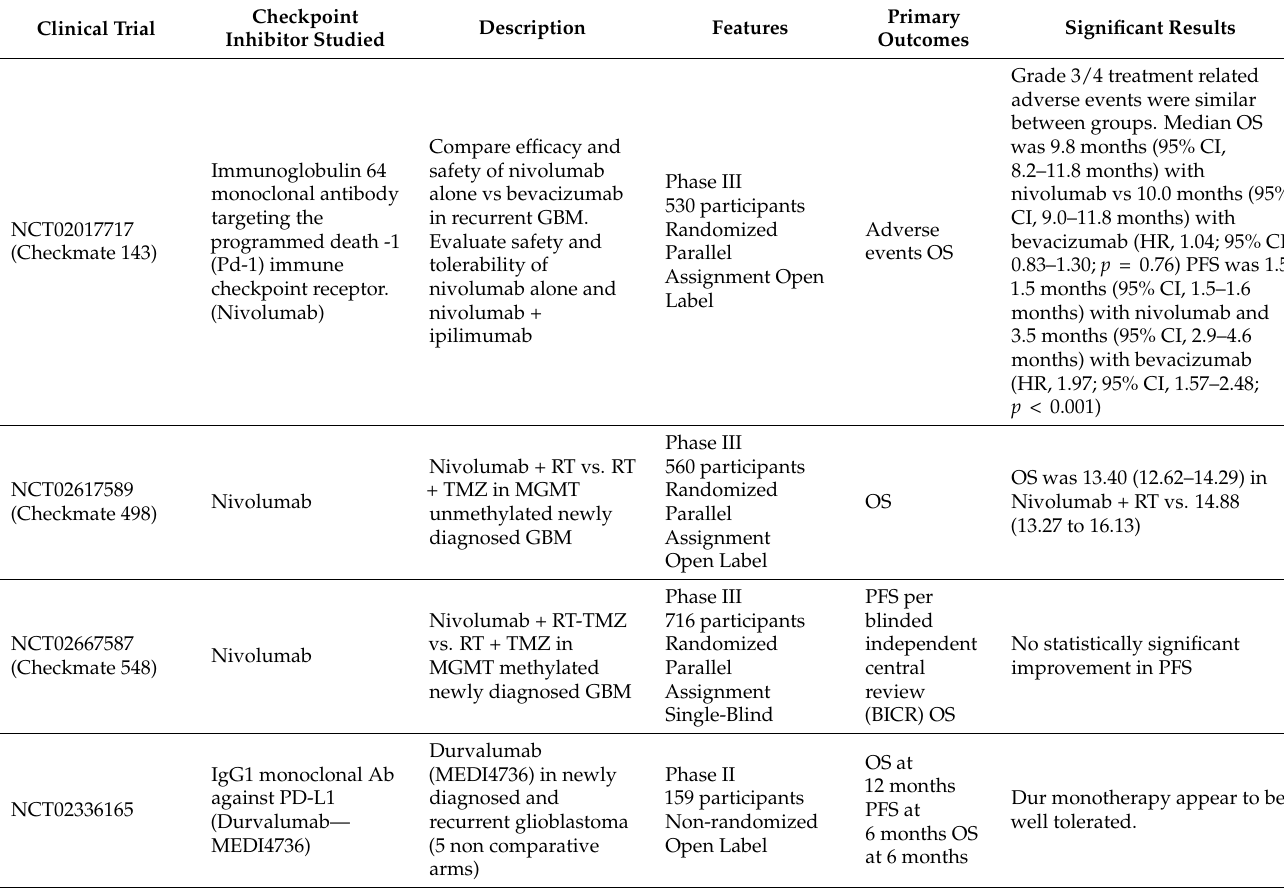
Table 3. Checkpoint Inhibitors